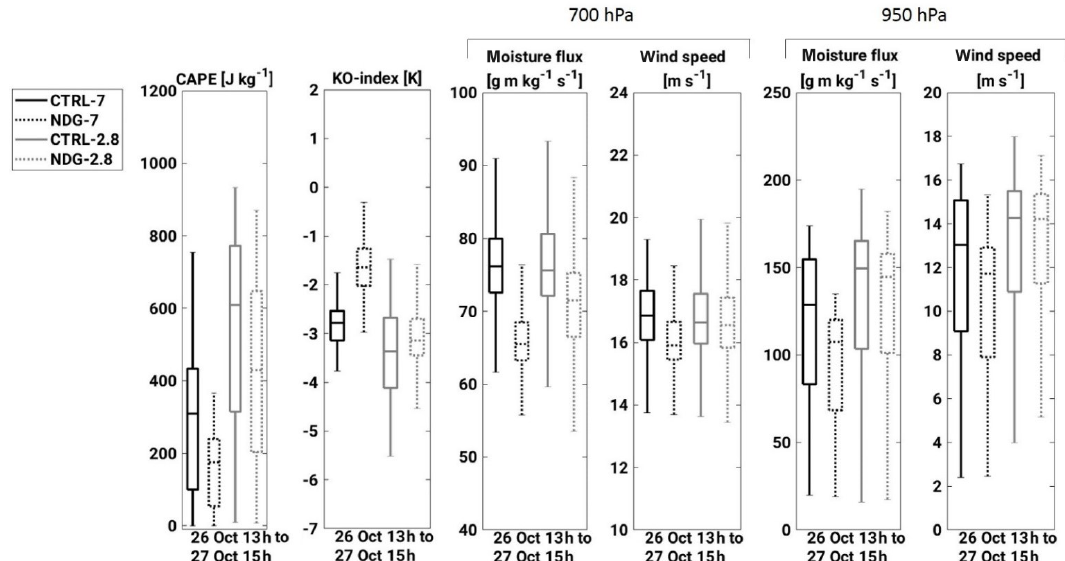
Figure 12. Box-and-whisker plots showing the median, the 25th and 75th percentiles and the extreme values of CAPE, the KO index, moisture flux and horizontal wind speeds. The box and whiskers are obtained from the distribution of values for the quantities shown between 26 October at 13:00UTC and 27 October at 15:00UTC over the study region